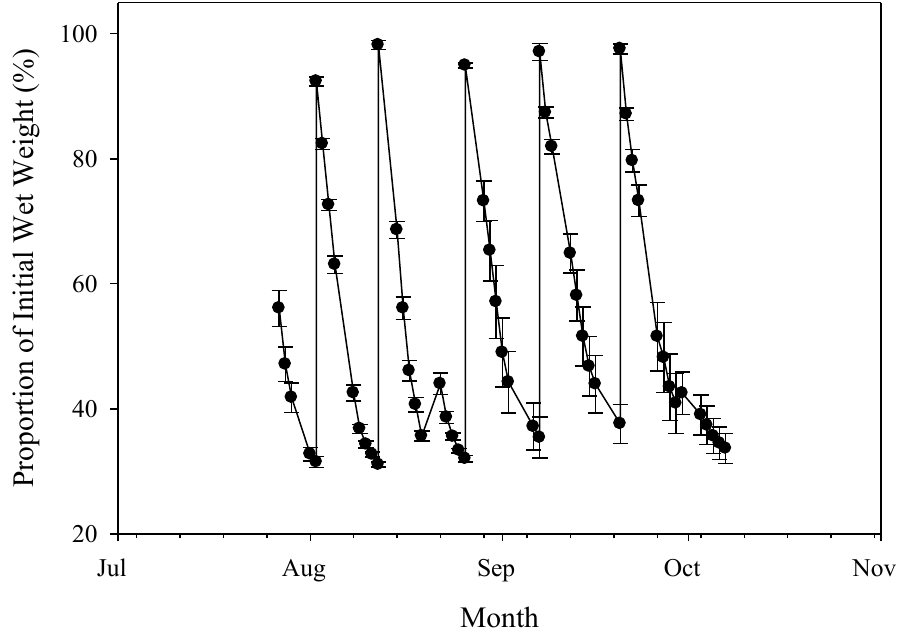
Figure 3. Gravimetric soil water content throughout the life cycle of the drought-grown wild oat plants. Error bars represent one standard error of the